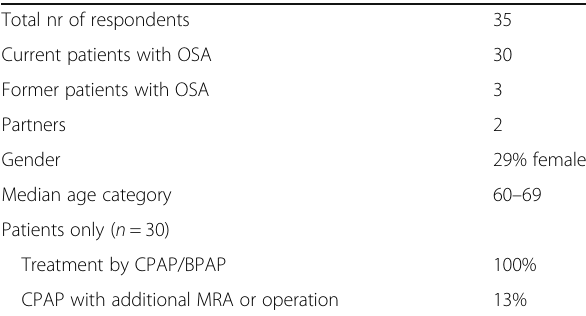
Table 1 Patient survey respondent characteristics